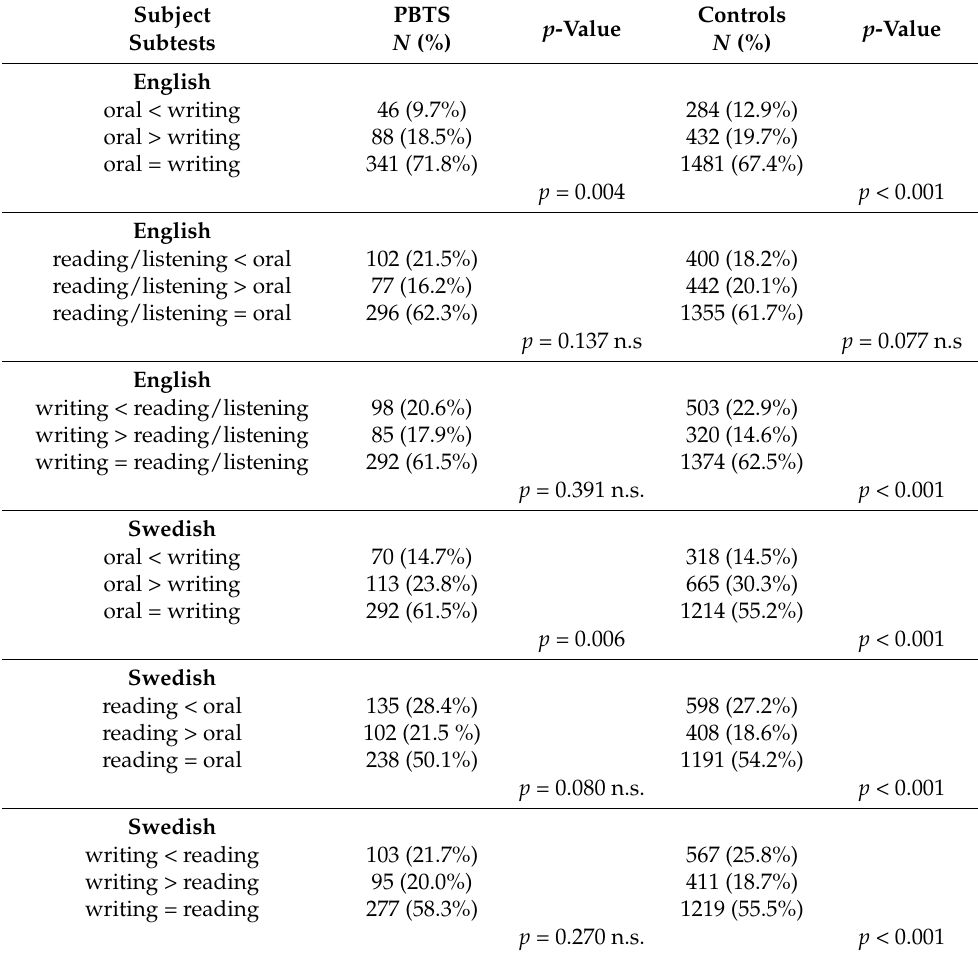
Table 7. Post hoc analysis with Wilcoxon signed-rank tests in the subjects English and Swedish for the PBTS ( n = 475) and controls ( n = 2, d2197), respectively. n.s. = not